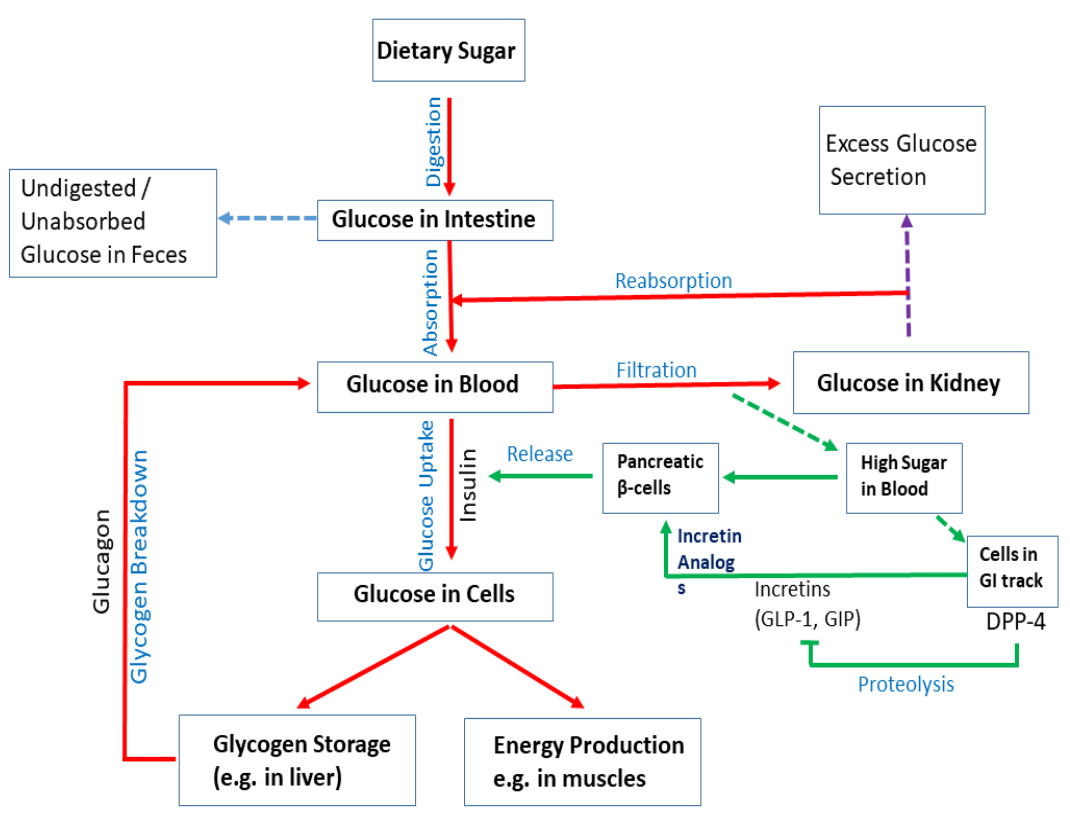
Figure 2. Mechanisms of diabetes. Upon digestion of dietary sugar, glucose is absorbed by the intestine, which causes an increase in the blood glucose level. Glucose levels increase in the blood and insulin is secreted by pancreatic β -cells. Insulin enhances uptake of glucose into cells. Glucose is stored as glycogen in the liver or utilized for energy production in muscles. If blood sugar levels are low, glucagon breaks down glycogen in the liver to release glucose and increase glucose levels. Intestinal cells secrete DPP4, which inhibits the production of incretins (e.g., GLP-1 and GIP). They act on pancreatic β -cells to regulate insulin production. Although glucagon induces hepatic glucose production, insulin acts as a potent inhibitor of glucose production when its concentration in the blood rises. Undigested/unabsorbed glucose is excreted from the body.